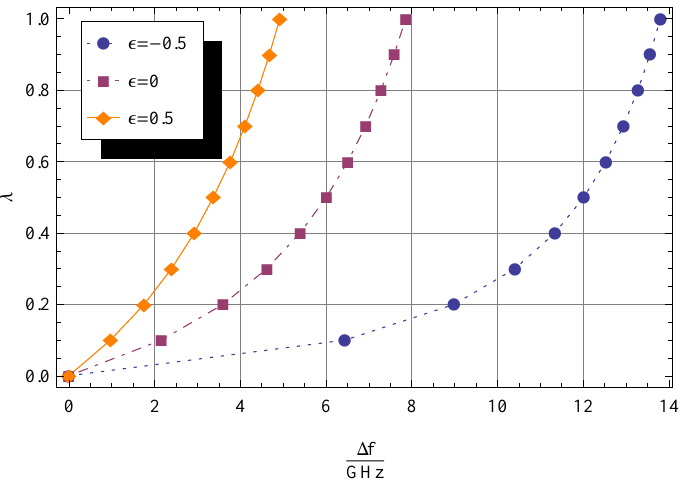
Figure 4. Dimensionless frequency shift ∆ f/GHz for 0 ≤ λ ≤ 1, and three different values of (cid:101) . The other parameters are q 1 = 1, q 2 = 1, η = 0.1, K R = 0, and K T = 0.